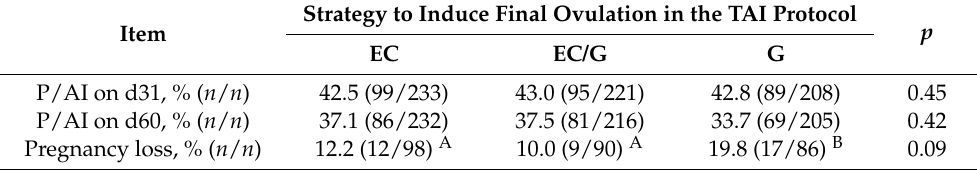
Table 4. Pregnancy per artificial insemination (P/AI) 31 and 60 d after timed AI (TAI) and pregnancy loss according to the strategy to induce final ovulation. EC (estradiol cypionate 48 h before TAI), EC/G (estradiol cypionate 48 and GnRH 16 h before TAI), and G (GnRH 16 h before TAI).